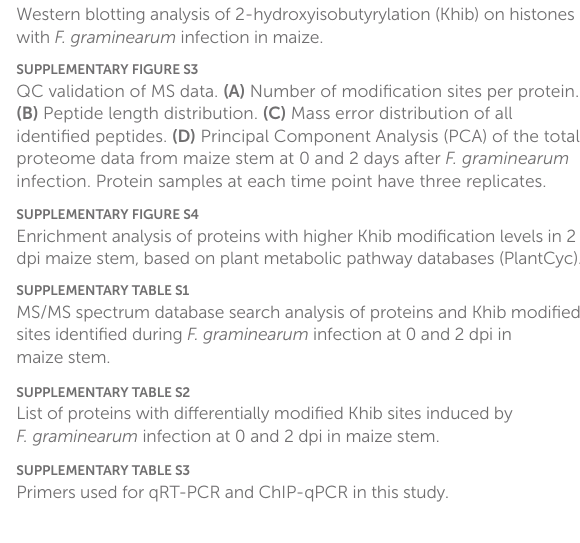
SUPPLEMENTARY FIGURE S1 Coomassie brilliant blue staining results of total protein 2-hydroxyisobutyrylation (Khib) (A) , crotonyllysine (Kcr) (B) ,